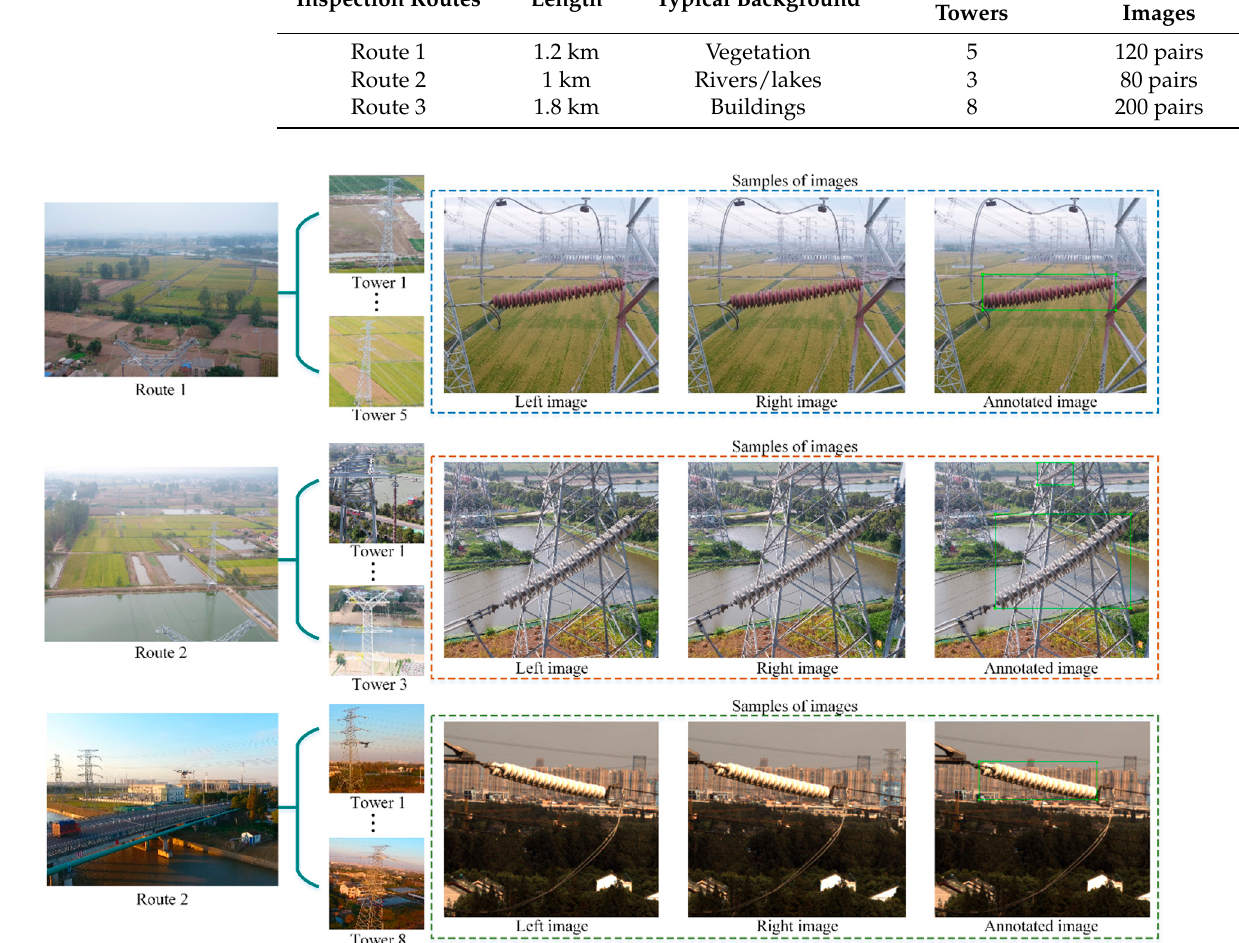
Figure 1. Samples of images in the dataset.